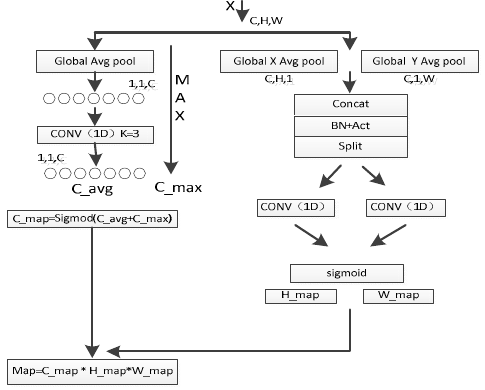
Figure 4. Dependency fusing attention network (DFAN) structure.